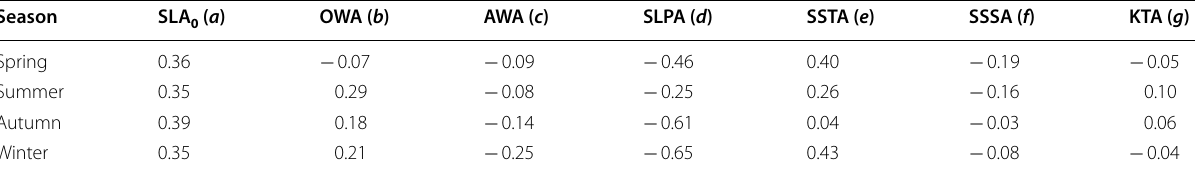
, OWA, AWA, SLPA, SSTA, SSSA and KTA south of the KE jet 0